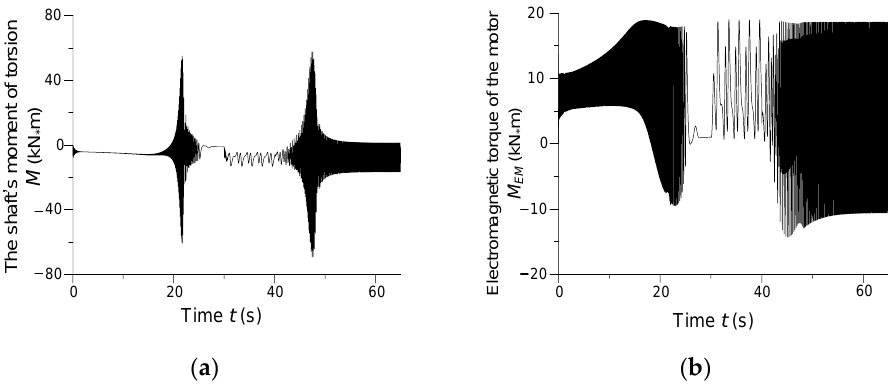
Figure 10. Instantaneous waveforms of: ( a ) moment of torsion in the middle section of the synchronous drive motion transmission long shaft; and ( b ) electromagnetic torque of the synchronous motor.